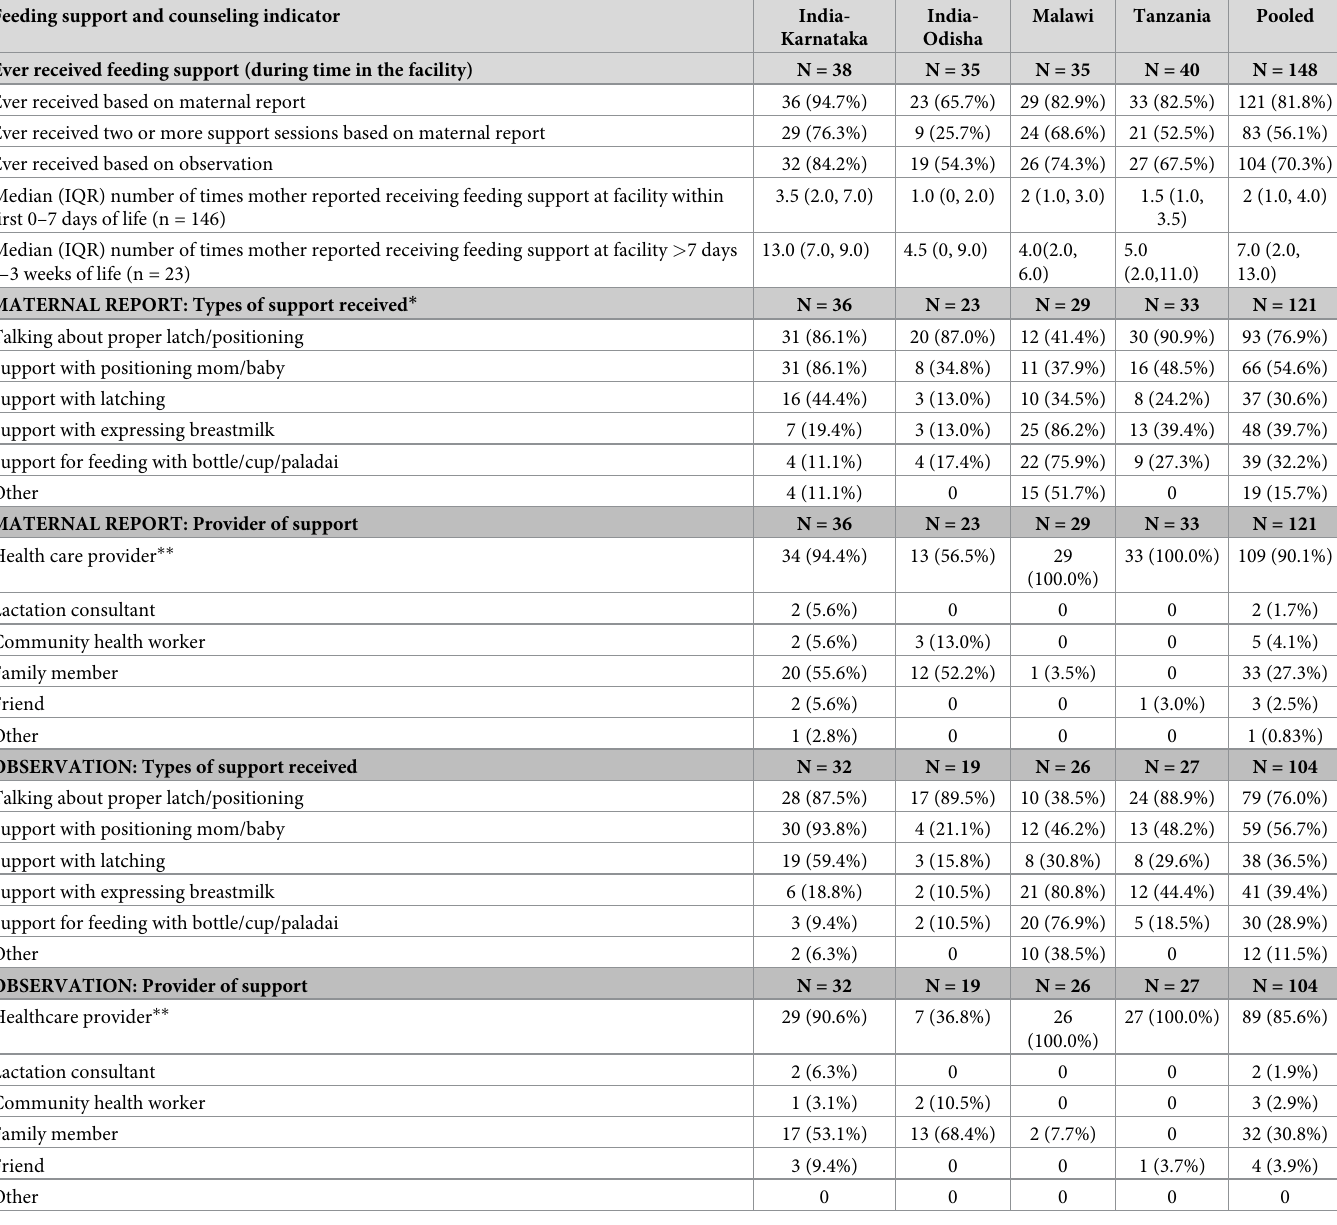
Table 4. Feeding support and counseling received in the facility based on maternal report and observations in a cohort of 148 moderately low birthweight infants in 12 facilities in India, Malawi, and Tanzania. Feeding support and counseling